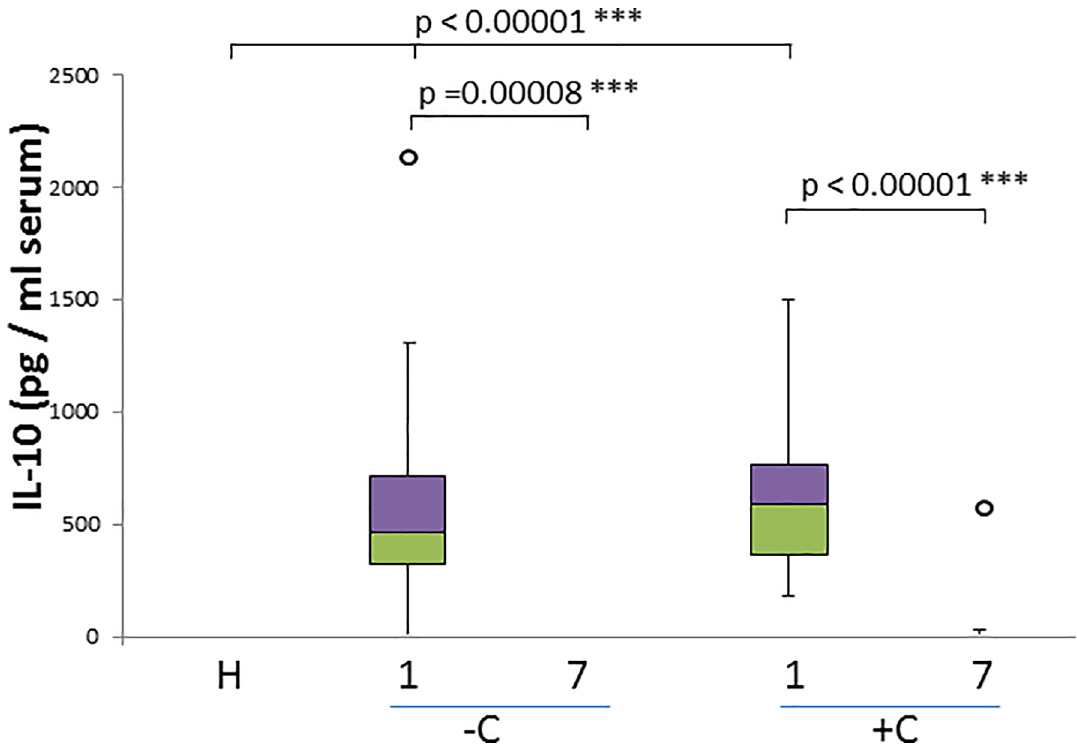
Fig 4. IL-10 concentration in healthy and naturally infected dogs and its relation with outcome. Box and whisker plot with outliersshowinginterquartile range (medianbar in intersect between two colors in box) of IL-10 concentration values among different groups: healthydogs (H), uncomplicated (-C) and complicated(+C) cases for both day 1 and day 7. Mann- whitney test p- values are shown for comparisonof different groups.